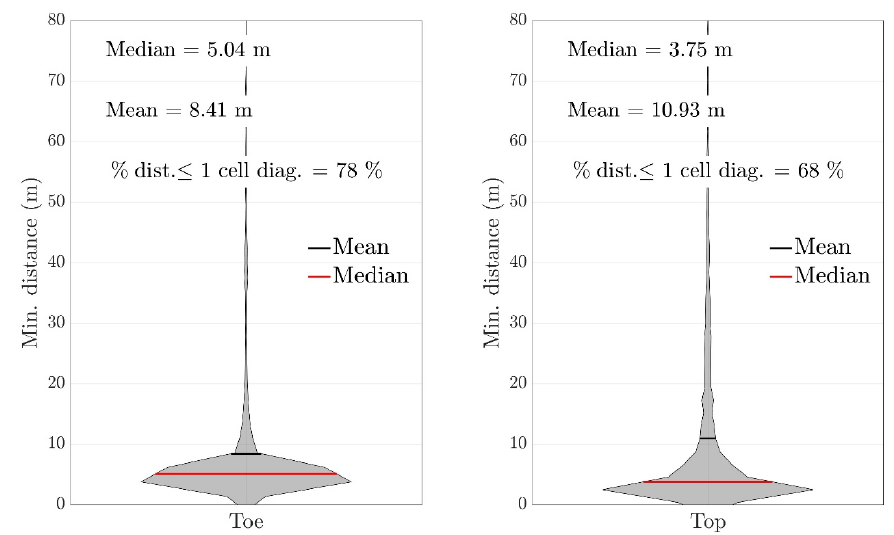
Figure 11. The proposed method and the PL2016 method outputs are in good agreement. Panels shows the distribution of the minimum distances between cliff toe and top output locations (for a 5m grid cell, the cell diagonal is 7.07m or the length of the hypotenuse of the square triangle made by two connected sides of the grid cell).